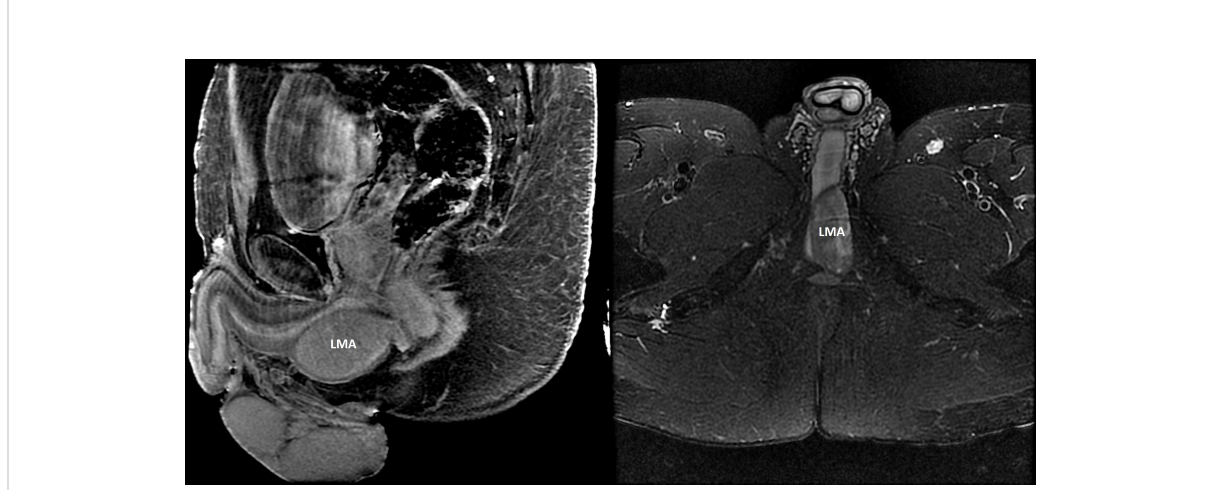
FIGURE 4 Leiomyoma (LMA). A 41-year-old man with MEN1 presented with an enlarging, painless perineal swelling. Magnetic resonance imaging (Left panel: contrast – enhanced sagittal T1-weighted fat suppressed image; right panel: axial T2-weighted fat suppressed image) identi fi ed a 5.8 x 2.6 x 3.8 cm mass in the perineum abutting the crus of the penis and the bulbous urethra. The mass was completely excised and histologic evaluation con fi rmed a leiomyoma. Somatic testing of the leiomyoma revealed the known germline pathogenic MEN1 variant and evidence for biallelic loss (loss of heterozygosity) at chromosome 11q (next-generation sequencing performed by Foundation Medicine; Cambridge, Massachusetts,